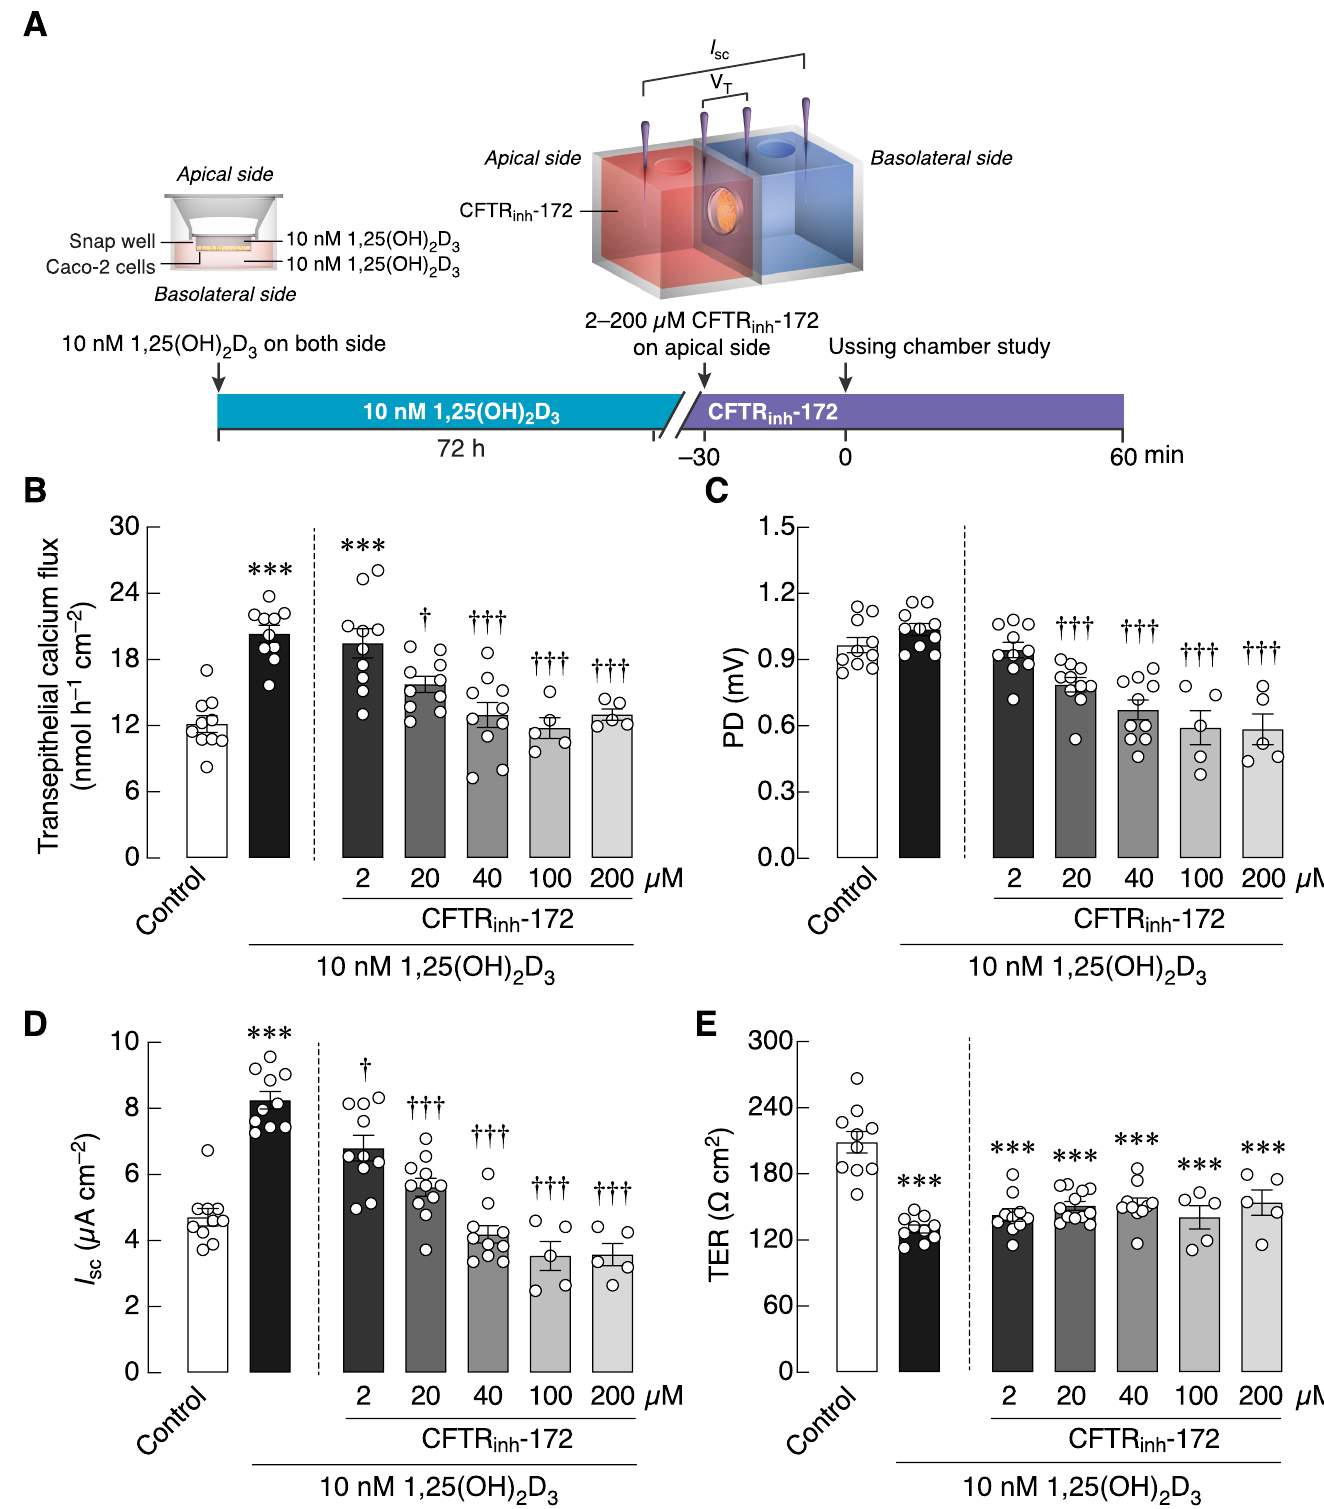
Fig 4. The effects of an CFTR inhibitor on transepithelial calcium transport. (A) Timeline of Experiment 3. (B) Transepithelial calcium flux and (C–E) epithelial electrical parameters (PD, I sc , and TER) across Caco-2 monolayers pretreated with 10 nM 1,25(OH) 2 D 3 for 72 h and then exposed to 2–200 μ M CFTR inhibitor (CFTR inh -172) on the apical side. ��� p < 0.001 vs. control group (open bar, one-way ANOVA with Tukey’s multiple comparison test). † p < 0.05; ††† p < 0.001 vs. 10 nM 1,25(OH) 2 D 3 -treated group (closed bar, one-way ANOVA with Tukey’s multiple comparison test). https://doi.org/10.1371/journal.pone.0277096.g004 PLOS ONE | https://doi.org/10.1371/journal.pone.0277096 November18,